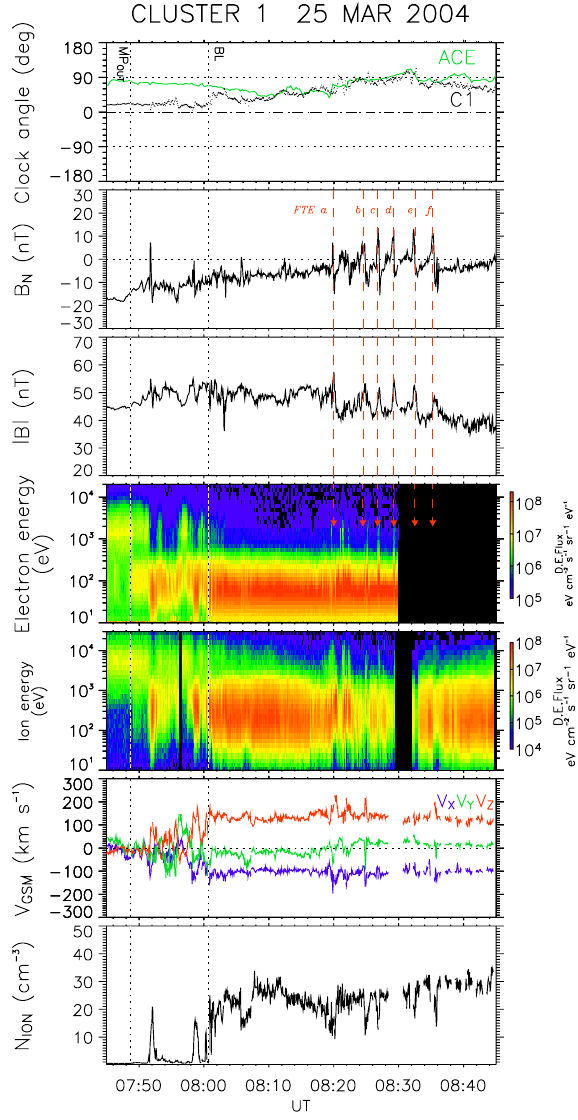
Fig. 5. Field and plasma measurements from the Cluster 1 space- craft between 07:45–08:45. From top-to-bottom, the panels present; the magnetic field clock angle measured at TC1 (black) and ACE (green); the component of the magnetic field normal to the local magnetopause; the overall magnetic field strength; an energy-time spectrogram of electrons moving parallel to the local magnetic field; an energy-time spectrogram of ions moving parallel to the local magnetic field measured by the CIS Hot Ion Analyser (HIA); GSM V X (blue), V Y (green) and V Z (red) components of the ion bulk flow velocity (also from CIS HIA); total ion density. Encounters with the boundary layer and magnetopause are indicated by dotted vertical line and labelled “BL” and “MP” respectively. The FTEs discussed in the text are indicated by dashed red